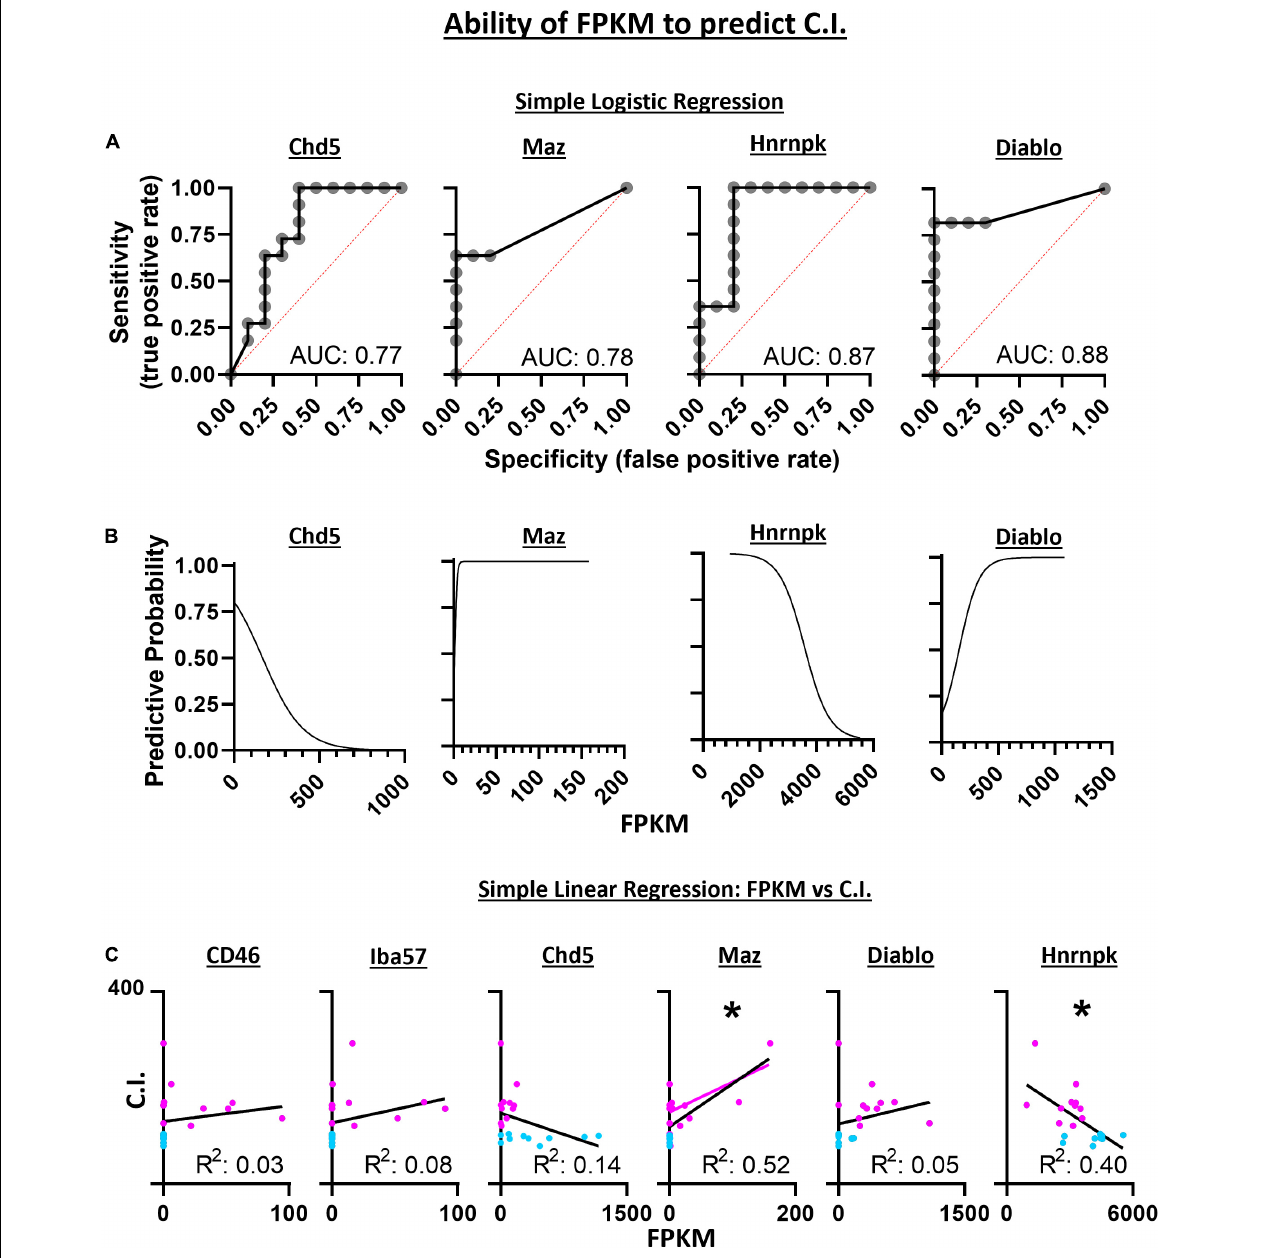
FIGURE 8 | Simple logistic regression indicates the expression level (FPKM) of Chd5 , Maz , Hnrnpk , and Diablo have high sensitivity and specificity with predictive accuracies (area under the curve) similar to the SVM-RFE analyses (A) . With increasing gene expression (FPKM), the predictive accuracy for assessing the chemosensitivity each neuron decreases for Chd5 and Hnrnpk but the accuracy increases within increasing Maz and Diablo gene expression (B) . The expression levels of Maz and Hnrnpk but not CD46 , Iba57 , Chd5 , or Diablo predict the degree of chemosensitivity of each 5-HT neuron assess by simple linear regression (C) . Maz and Hnrnpk have significant R 2 values indicating their FPKM values account for a significant degree of the C.I. variability with a significant positive and negative Pearson r correlation, respectively. * P < 0.002; Pearson r